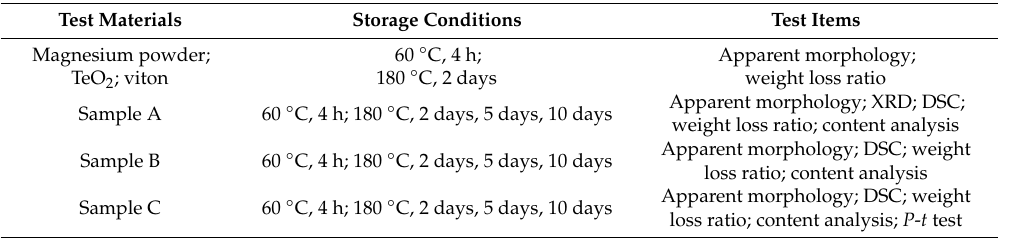
Table 1. Thermal stability analysis test items and storage conditions corresponding to di ff erent test